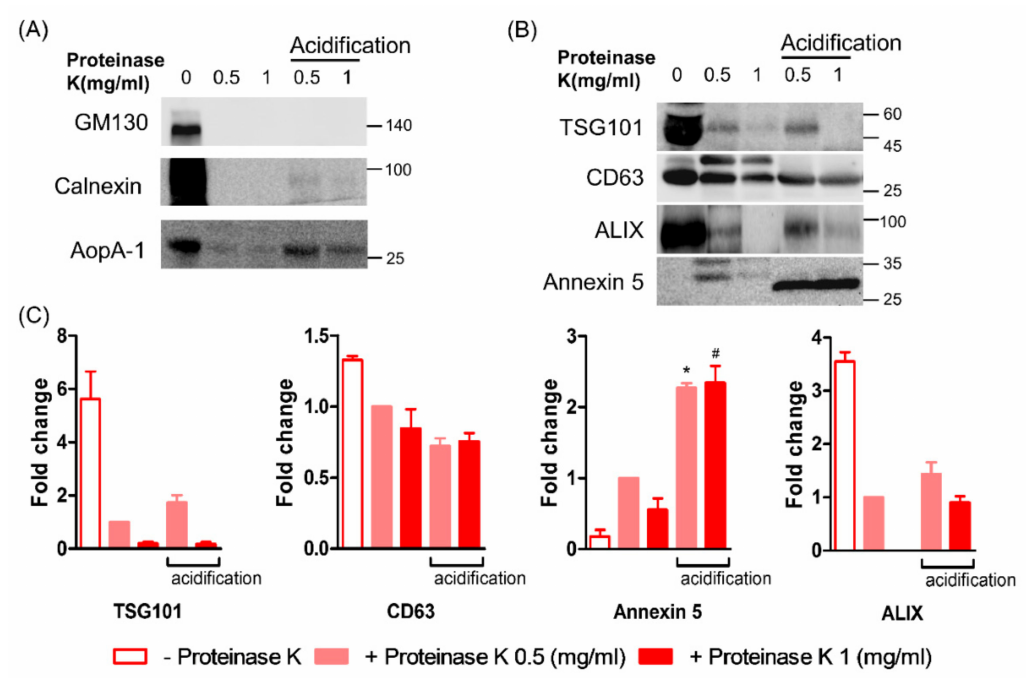
Figure 4. E ff ect of acidification on the level of exosomal and non-exosomal proteins in ELV preparation. ( A ) Levels of non-exosomal proteins (GM130, calnexin, and ApoA-1) were scanty by treatment of proteinase K, while the acidification slightly increased the expression of calnexin and ApoA-1, but not GM130. ( B,C )Amongtheexosomalmarkers(TSG101, CD63, Alix, andannexin5), acidificationincreased the level of TSG101, Alix, and annexin 5, as compared with non-acidified, but proteinase-treated ELVs preparation, while the level of CD63 was comparable. Representative bands were shown (n = 6). * p < 0.05 vs. ELV with proteinase K 0.5 mg / mL without acidification; # < 0.05 vs. ELV with